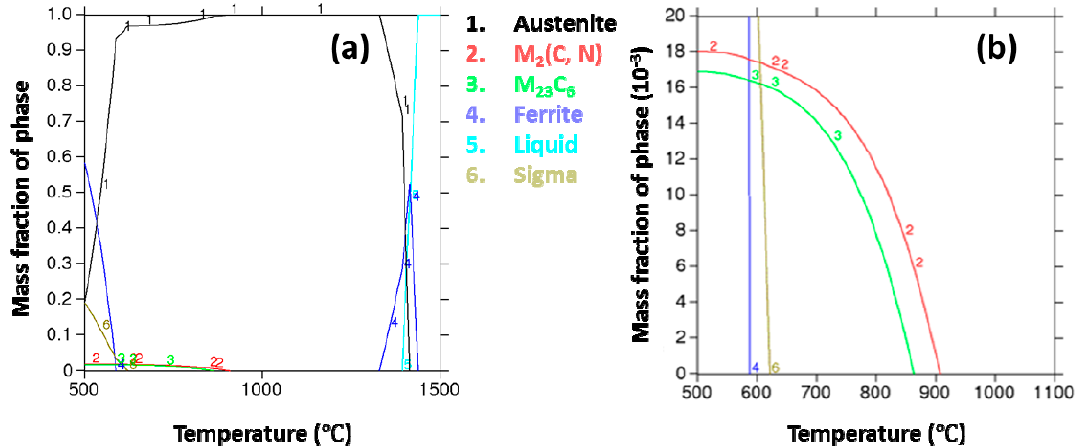
Figure 1. ( a ) Mass fraction of equilibrium phases for the Cr–Mn–Ni–N–Cu austenitic stainless steel determined by thermodynamic calculation; ( b ) is the partially amplified plot of ( a ). This calculation was conducted by Baosteel Co., Ltd. using Thermo-Calc with a TCFE4